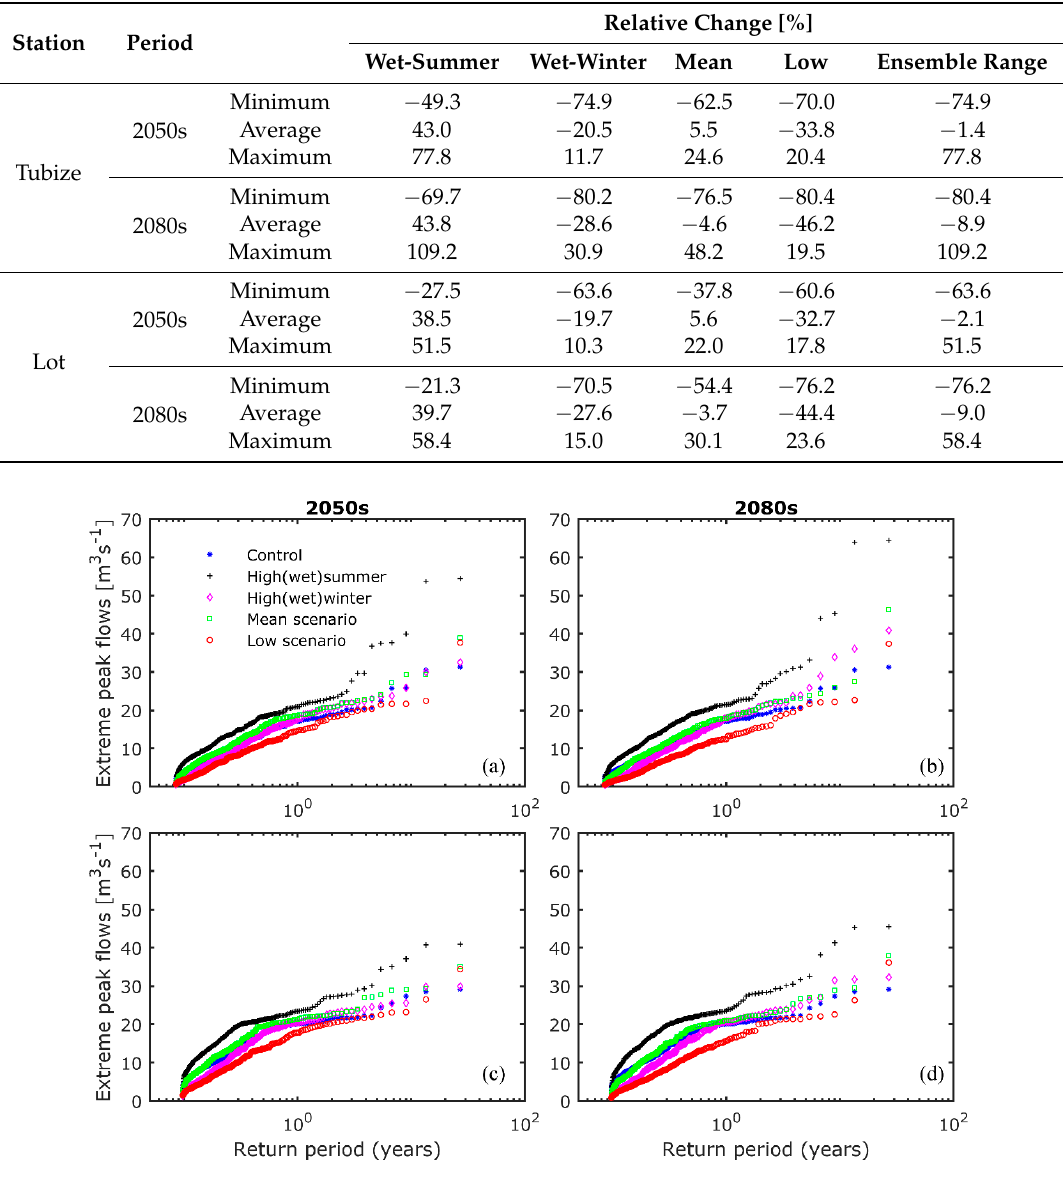
Figure 4 . Simulated daily extreme peak flows of Zenne for the control and future climate change scenarios at Tubize ( a , b ) and Lot ( c , d ).